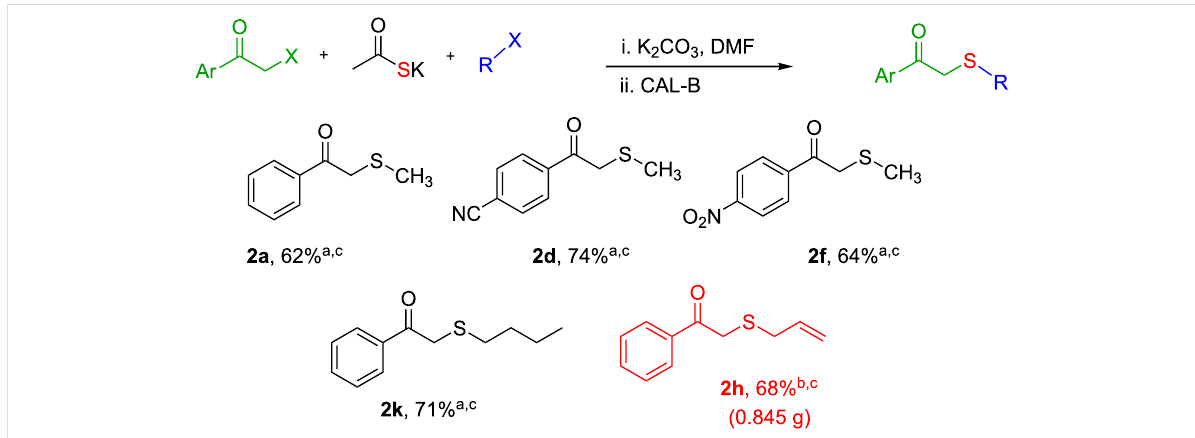
Scheme 3: One-pot two-step preparation of phenacylalkylsulfides. a Reaction conditions: i. α -haloketone (0.25 mmol), potassium thioacetate (1.1 equiv), alkyl halide (1.1 equiv) and K 2 CO 3 (2.0 equiv) in 500 µL of DMSO, 5 h at room temperature; ii. 100 mg of CAL-B (Novozyme 435)